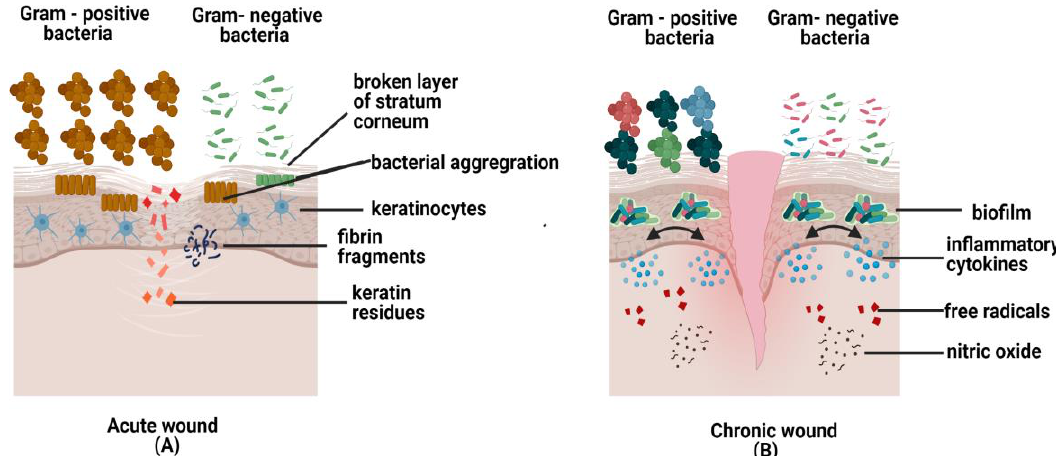
Figure 5. The figures above show microbes in acute and chronic wounds. ( A ) In acute wounds, fibrin fragments and keratin residues are favorable conditions for pathogens invasion into the skin. Hence, bacteria aggregate to prevent immune cells from destroying the bacterial community; ( B ) In chronic wounds, the biofilm formation secretes inflammatory cytokines, free radicals, and nitric oxide, which are toxic to cells and cell apoptosis.